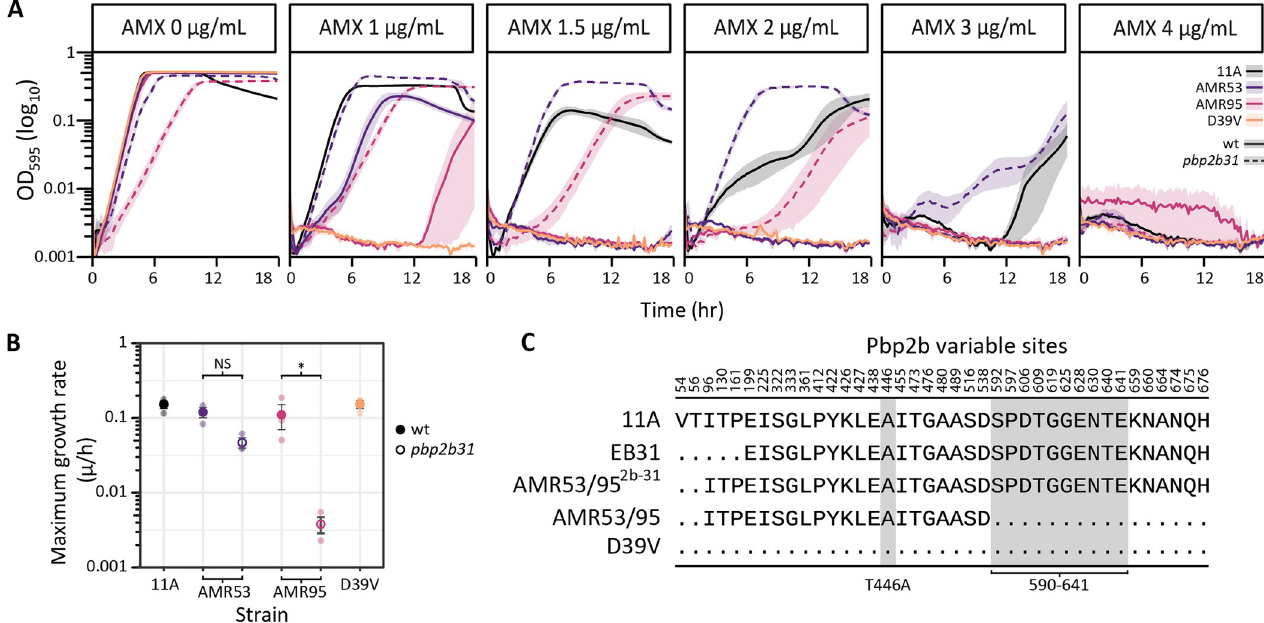
Fig 9. Ten substitutions in Pbp2b 590–641 region essential for high AMX resistance. (A) Growth of AMR53 2b31 and AMR95 2b31 (dotted lines) in different AMX concentrations. 11A, D39V, AMR53, and AMR95 (solid lines) are shown as controls. (B) Dot plot of maximum specific growth rates ( μ /h) calculated from the AMX 0 μ g/mL condition in triplicate (transparent circles). The mean for each strain is shown by an opaque circle, solid for wild-type (wt) strains and empty for AMR53 2b31 and AMR95 2b31 . Color denotes strain background. Significance was determined by one-way ANOVA with a Tukey correction for multiple testing. (C) Amino acid sites in pbp2b which differ from D39V for strains 11A, EB31, AMR53 (identical to AMR95), and AMR53 2b31 (the result of transforming AMR53 or AMR95 with the EB31 pbp2b allele). Dots indicate the amino acid matches D39V, and key substitutions, T446A and a block of 10 between 590–641 [54–56], are highlighted in